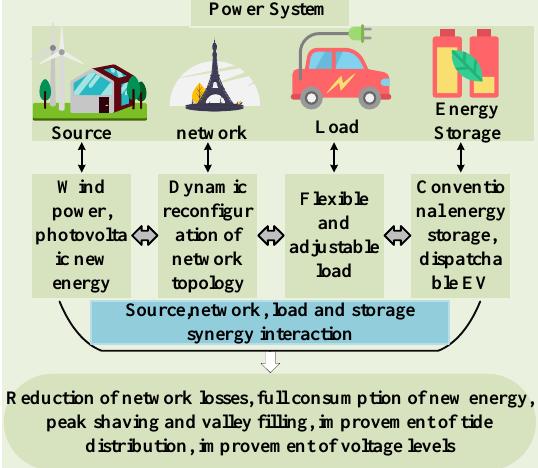
Figure 4. Schematic diagram of the optimal scheduling model based on the coordinated interaction of source, network, load, and storage.